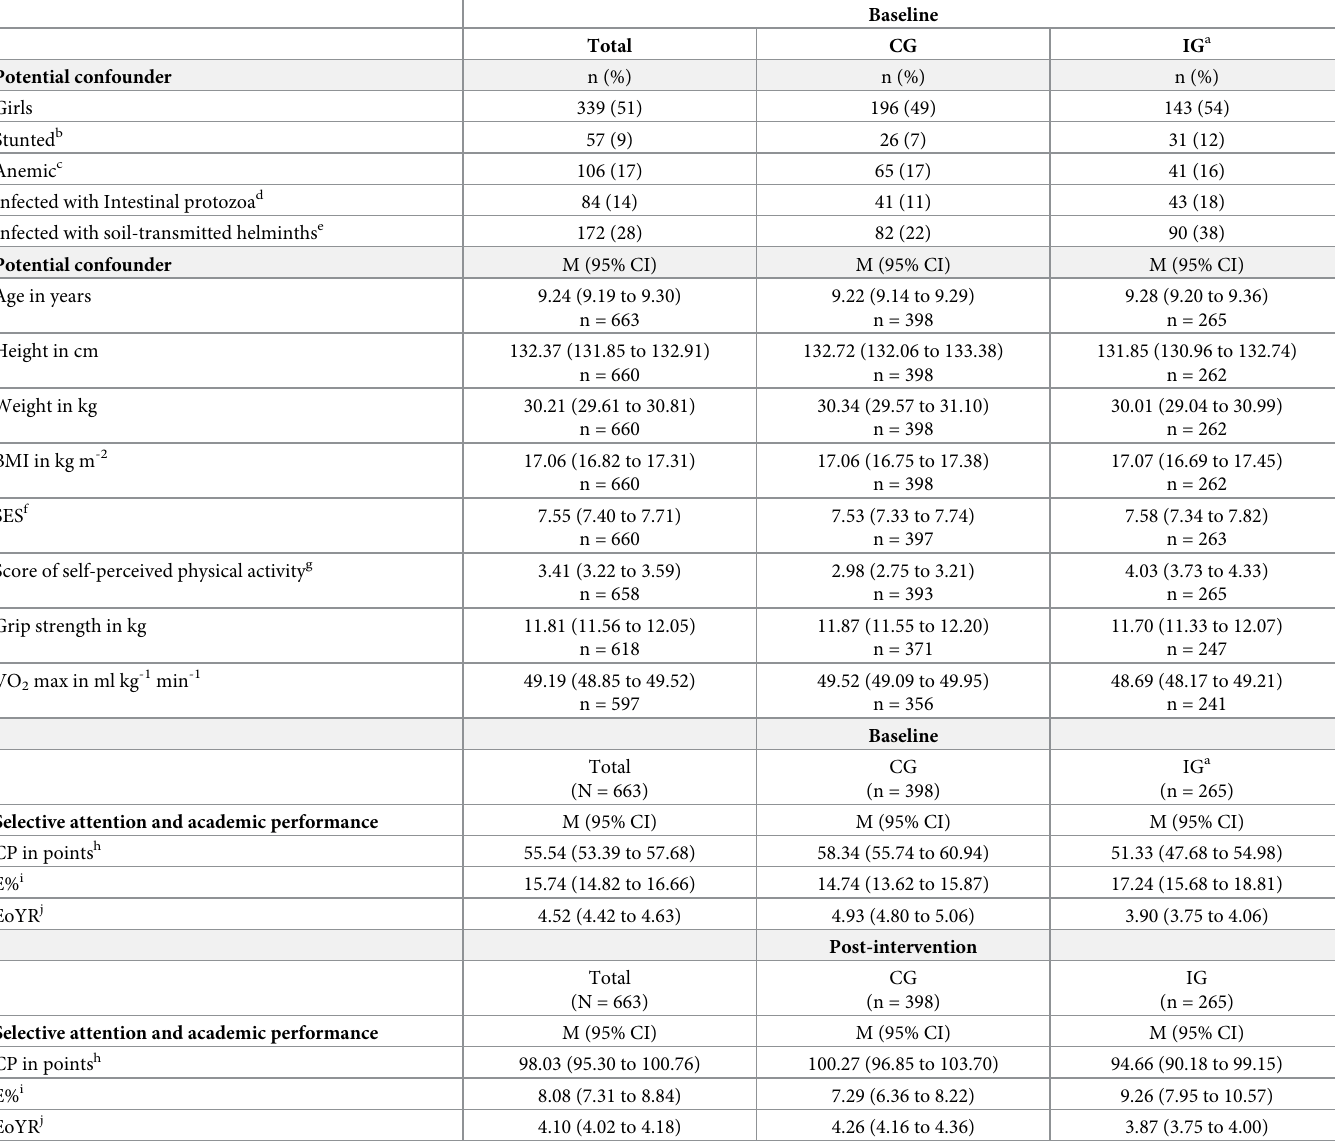
Table 2. Descriptive statistics of all variables at baseline in February 2015 and outcome/dependent variables also at post-intervention in May 2016, Port Elizabeth, South